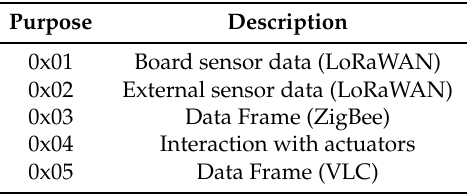
Table 1. Types of frames considered in this work.